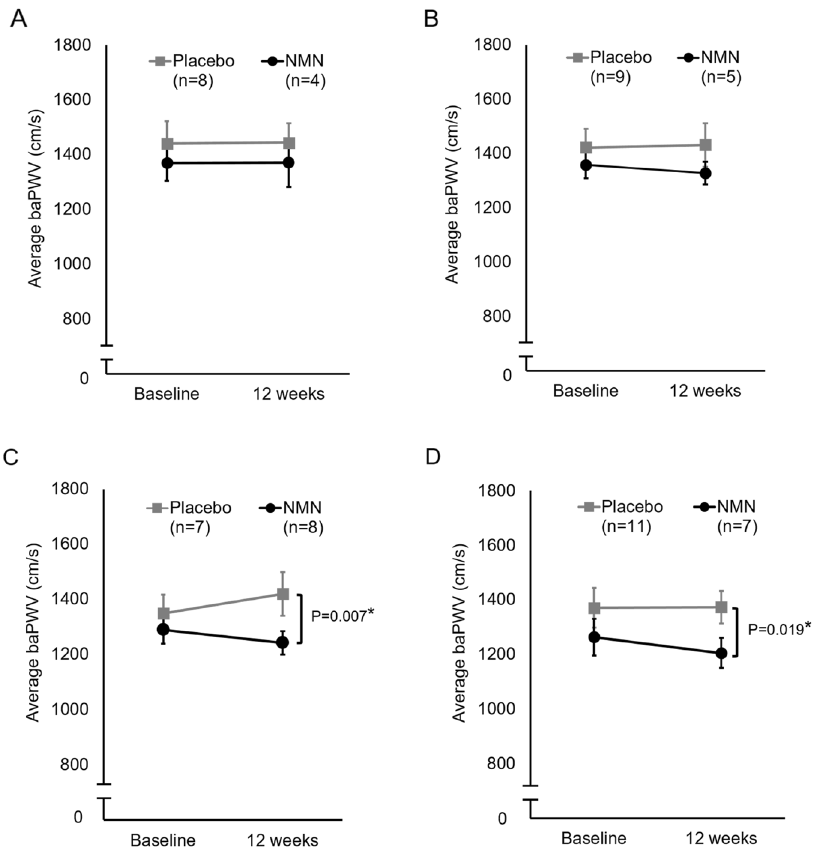
Figure 3. Subgroup analyses of NMN and placebo groups for baPWV. ( A ) Subjects with above-average systolic blood pressure, ( B ) subjects with above-average diastolic blood pressure, ( C ) subjects with above-average BMI, and ( D ) subjects with above-average blood glucose levels. Values are expressed as mean ± standard